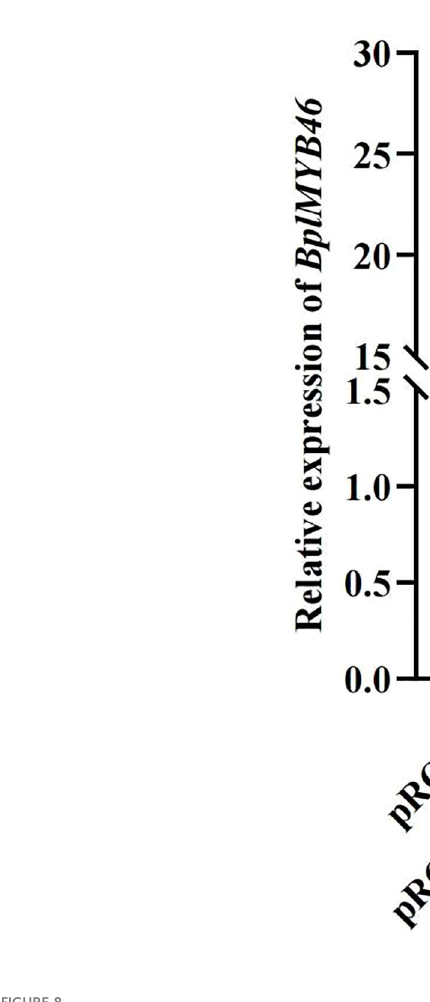
FIGURE 8 The relative expression levels of BplMYB46 . The effector, including pROKII-35S:: BpDof1 , pROKII-35S:: BpWRKY3 and pROKII-35S:: BpbZIP3 , was transiently transformed into one-month-old birch plants, respectively. The plants transformed with the empty pROKII vector were used as the control. Error bars indicate the standard deviation of three biological